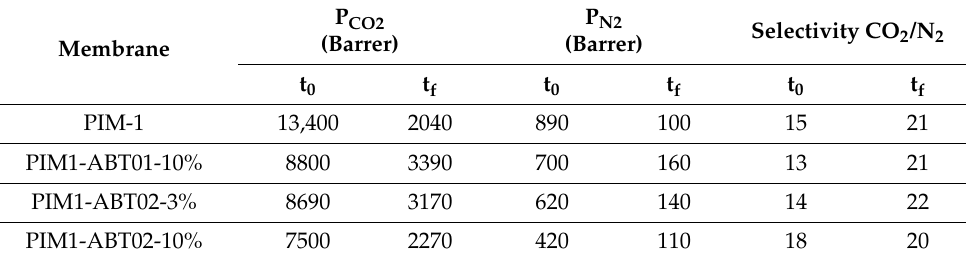
Table 4. CO 2 and N 2 permeability coefficients and selectivity data of PIM-1,